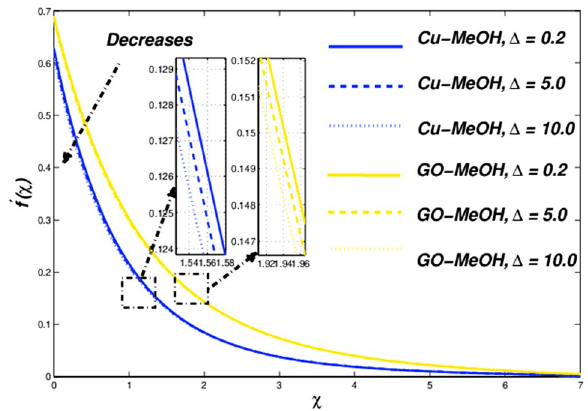
Figure 4. Velocity variation versus (cid:31) .